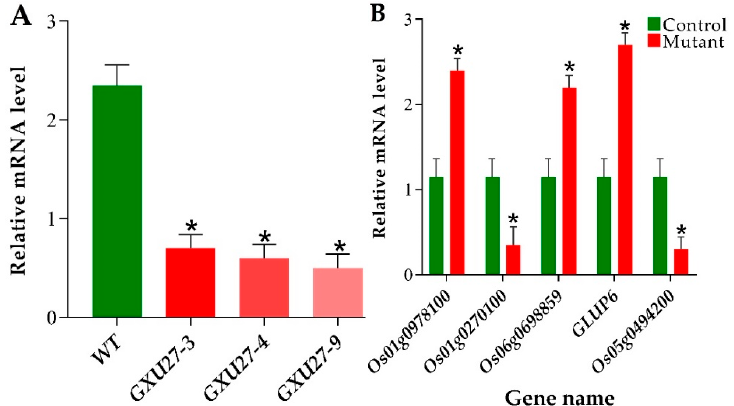
Figure 7. RT-qPCR-based assessment of GS3 expression and validation of proteomic experiment. ( A ) The expression level of GS3 in wild-type (WT) and mutant plants. ( B ) Expression analysis of five selected genes associated with differentially expressed proteins (DEPs). * Denotes a significant difference, Student’s t -test, p ≤ 0.01, n =